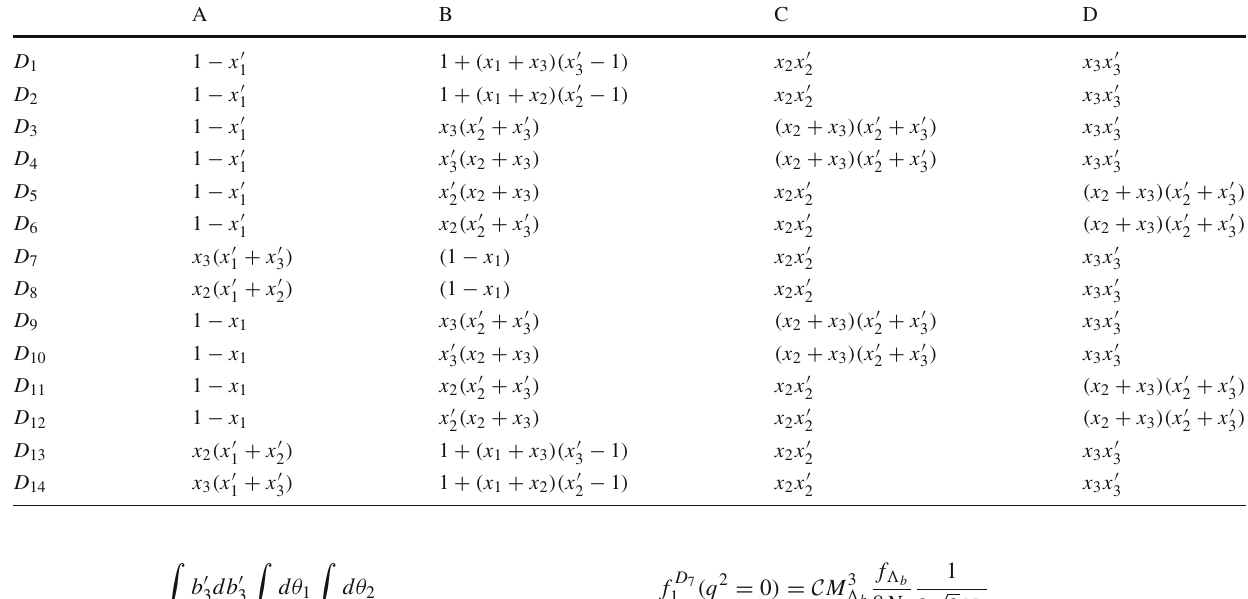
Table 13 Auxiliary functions A , B , C and D . An overall coefficient m 2 (cid:2)